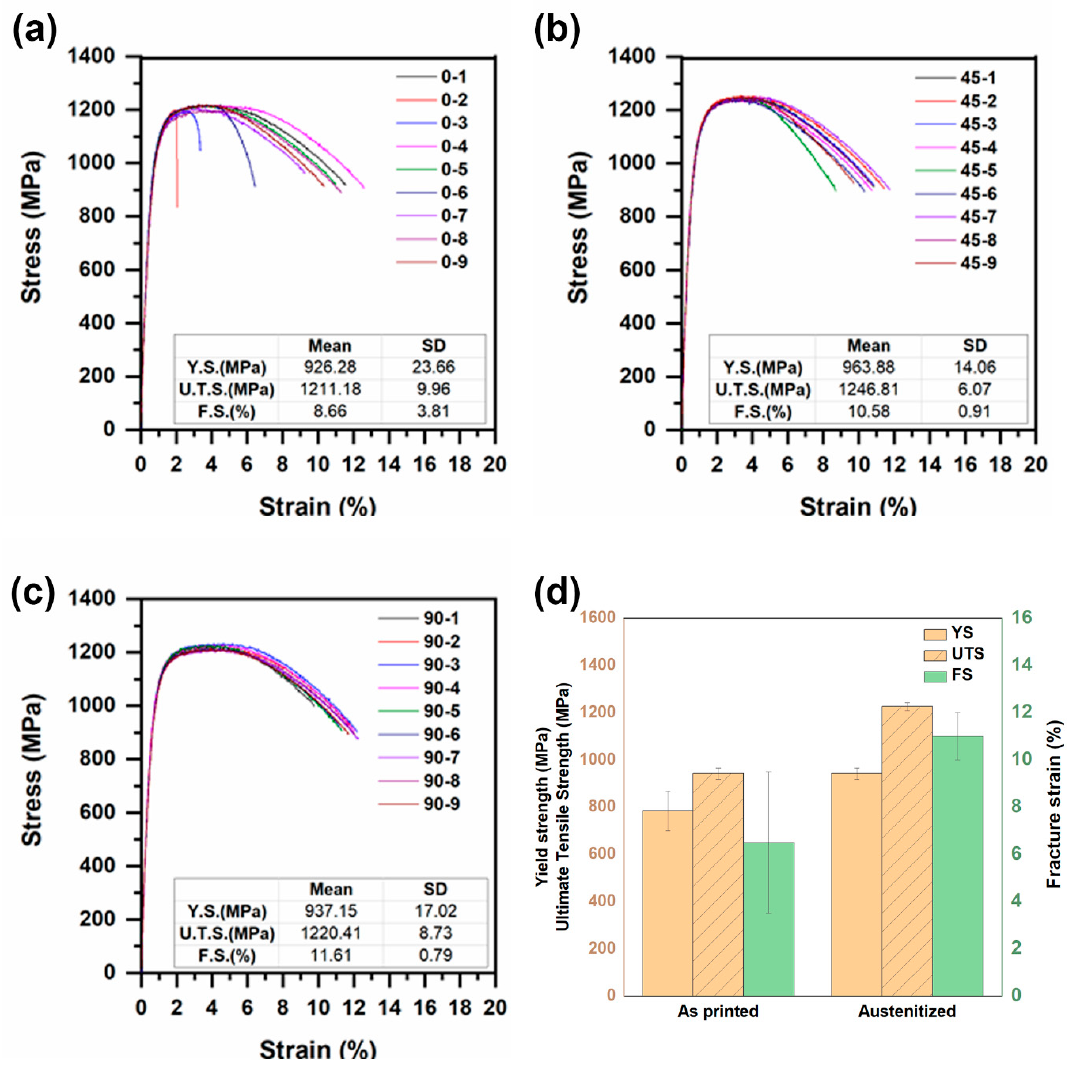
Figure 9. Stress versus strain curves ( a ) perpendicular; ( b ) 45°; ( c ) parallel to build direction for austenitized samples. ( d ) Comparative bar graph of yield stress, ultimate tensile stress, and fracture strain data in as-printed and austenitized samples. (Here, Y.S., U.T.S. and F.S. denote yield strength, ultimate tensile strength, and fracture strain, respectively.)